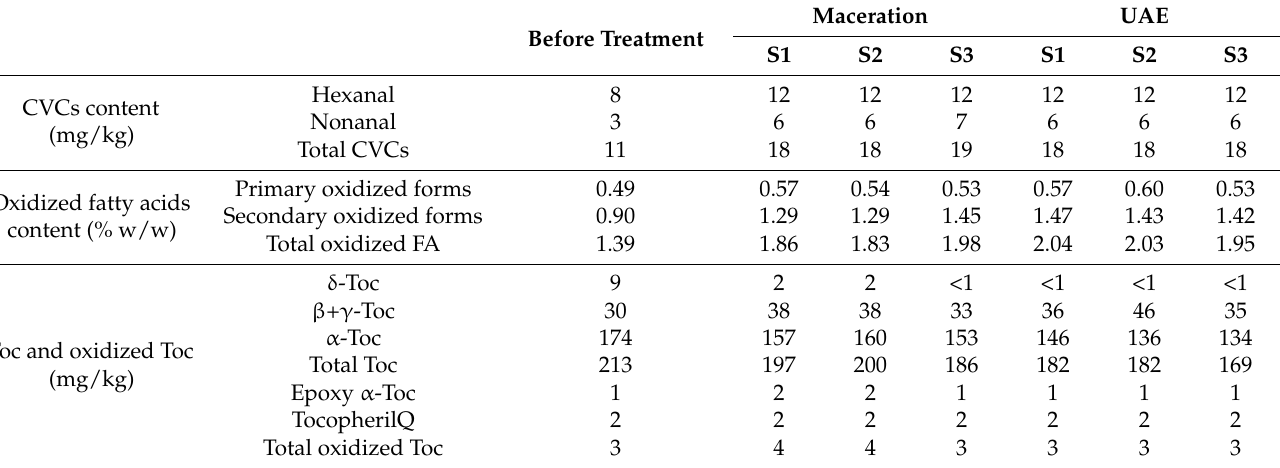
Table 7. Olive oil characterization before and after treatment, maceration or UAE.